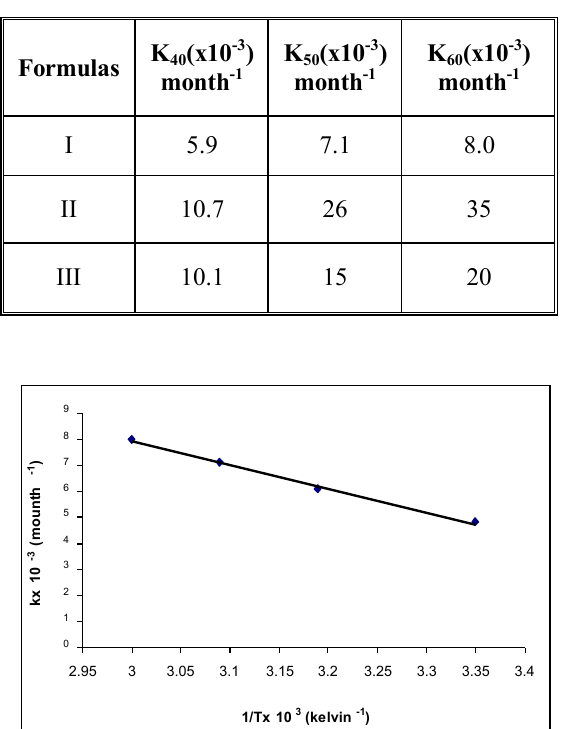
Table (3): Degradation rate constants of frusemide in formulas I, II, III at 40, 50 and 60 0 C.